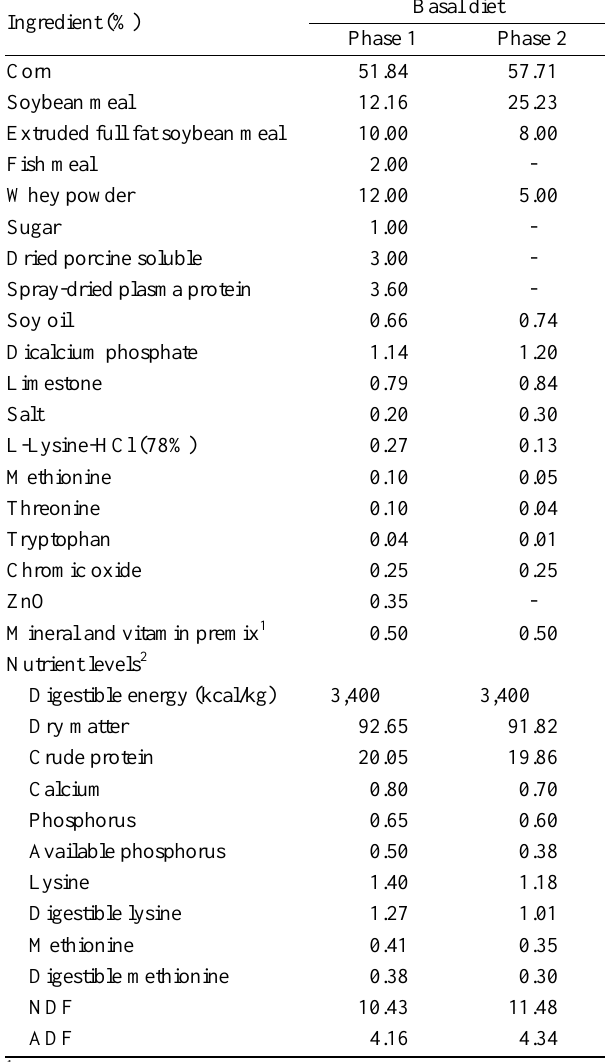
Table 1. Diet composition and nutrients levels of experimental diets fed to determine the effects of enzyme